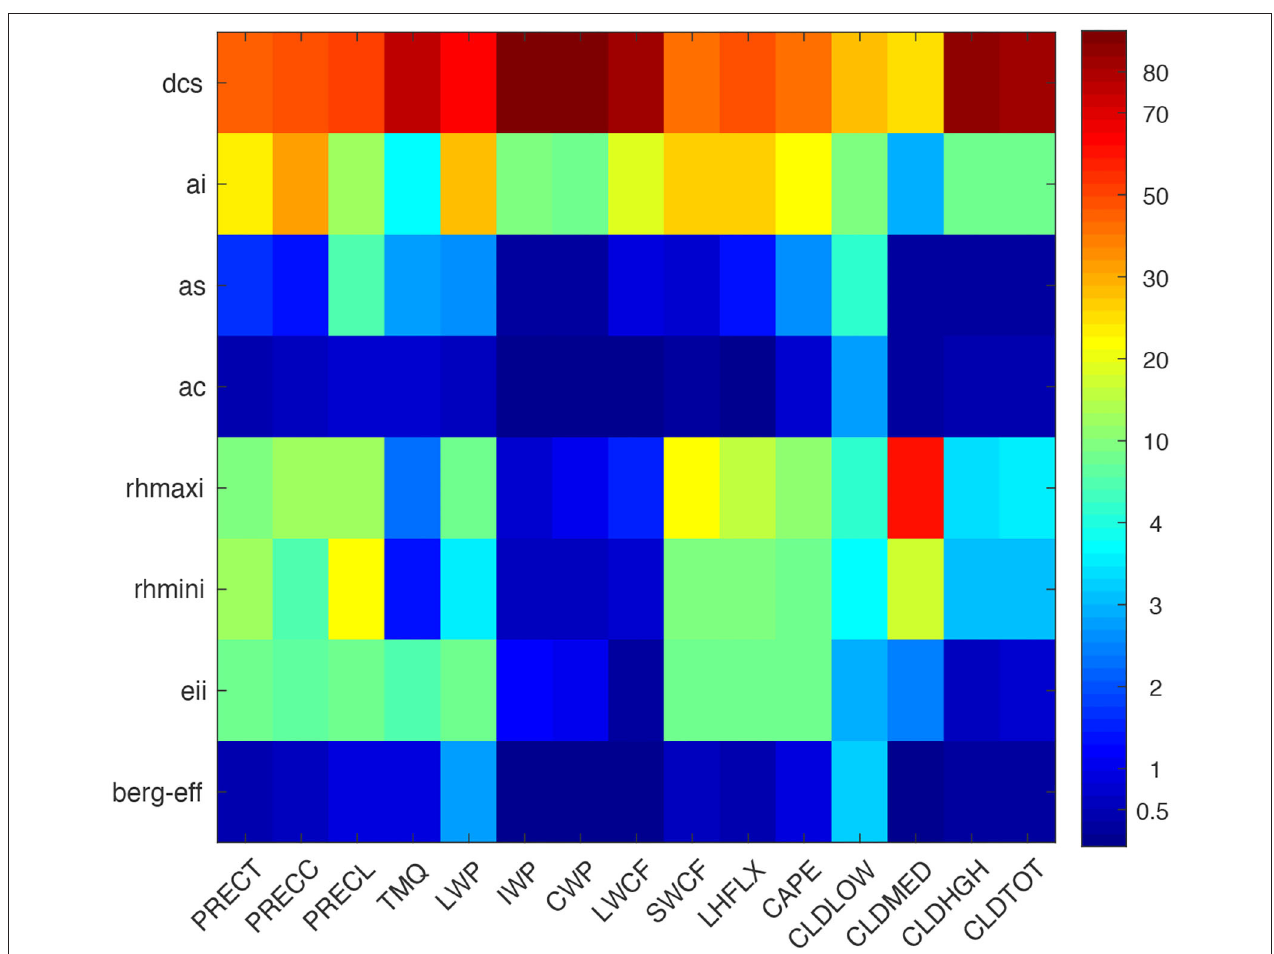
FIGURE 6 | Total contribution of each parameter to the total explained variance (in %) from PC-fitted outputs against SCAM6 simulations for various climatic variables. A larger number indicates greater